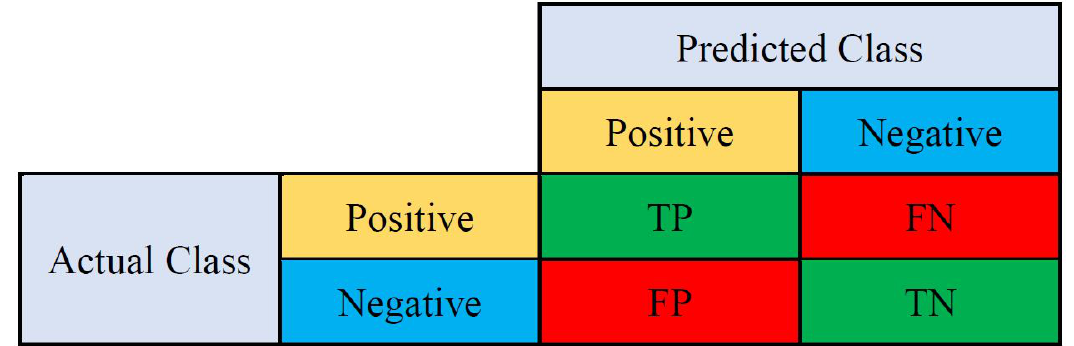
Figure 5. Confusion matrix, where TP = true positives, TN = true negatives, FP = false positives and FN = false